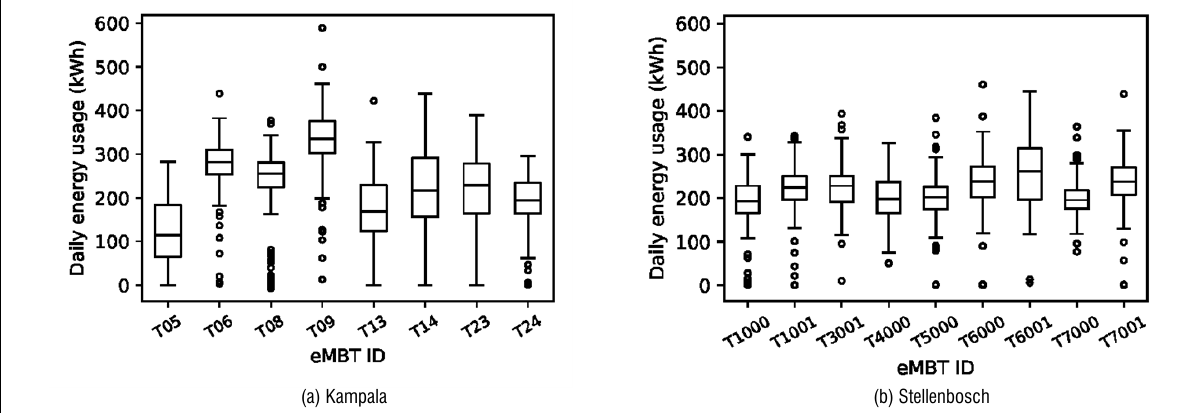
Figure 3: Daily energy usage for each simulated electric minibus taxis To illustrate the difference between the two data source methods, in Figure 4 we show Kampala’s energy profile from the two vantage points. The overlay shows the passenger-based energy profile, which was down-scaled by the number of taxis in Kampala (25 000 according to Spooner et al. 25 ), and our vehicle-based energy profile.